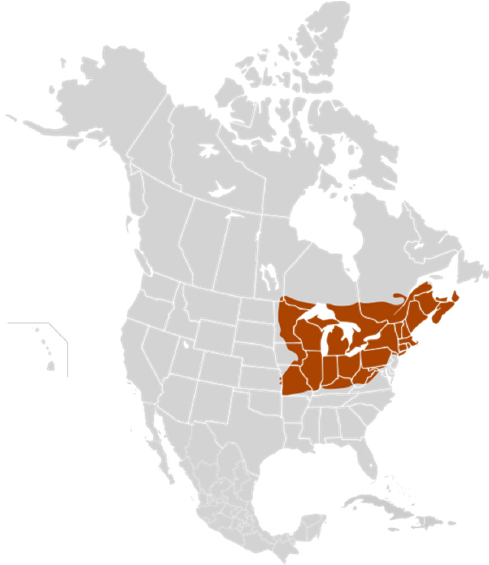
Figure 1. Regions of maple syrup production in Canada and the USA according to the Maple Syrup Producers’ Association of Ontario [94]. Table 5. Maple syrup production [95] per province (in thousands of gallons).